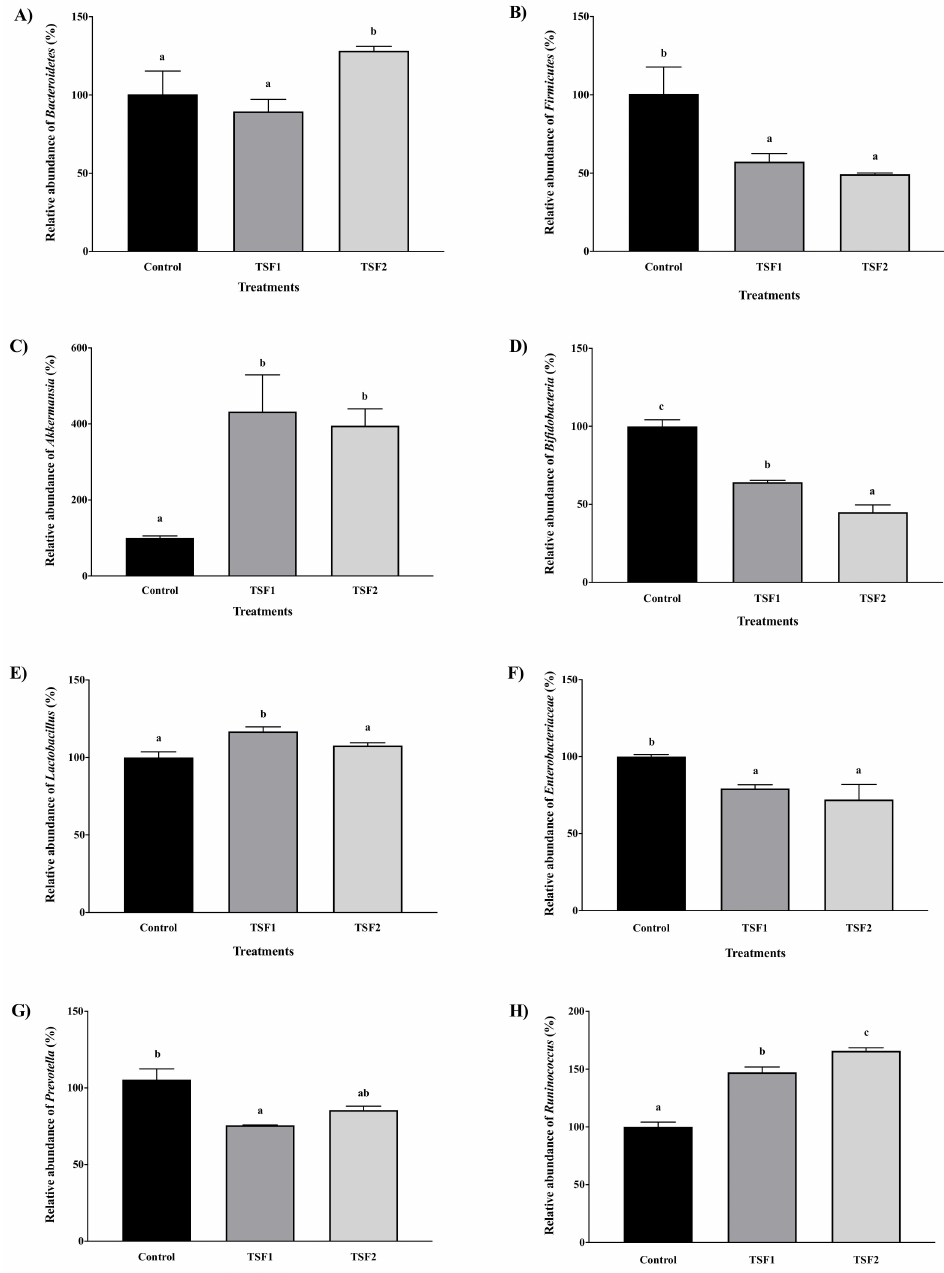
Figure 4. Gut microbiota profile modulation of tomato seed flour extracts, ( A ) Bacteroidetes phylum, ( B ) Firmicutes phylum, ( C ) Akkermansia genus, ( D ) Bifidobacterium genus, ( E ) Lactobacillus genus, ( F ) Enterobacteriaceae genus, ( G ) Prevotella genus, and ( H ) Ruminococcus genus. Control, No-treatment; TSF1 and TSF2 represent the first and the second batches of tomato seed flour extracts, respectively; different letters demonstrate a significant difference ( p ≤